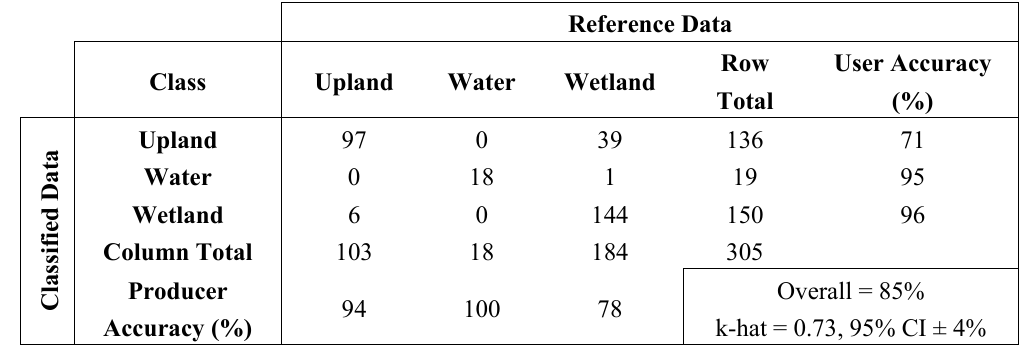
Table 5. Classification error matrix for the most accurate full season random forest model for the Level 1 classification which incorporated all available Landsat 5 TM, topographic, PALSAR, and soils